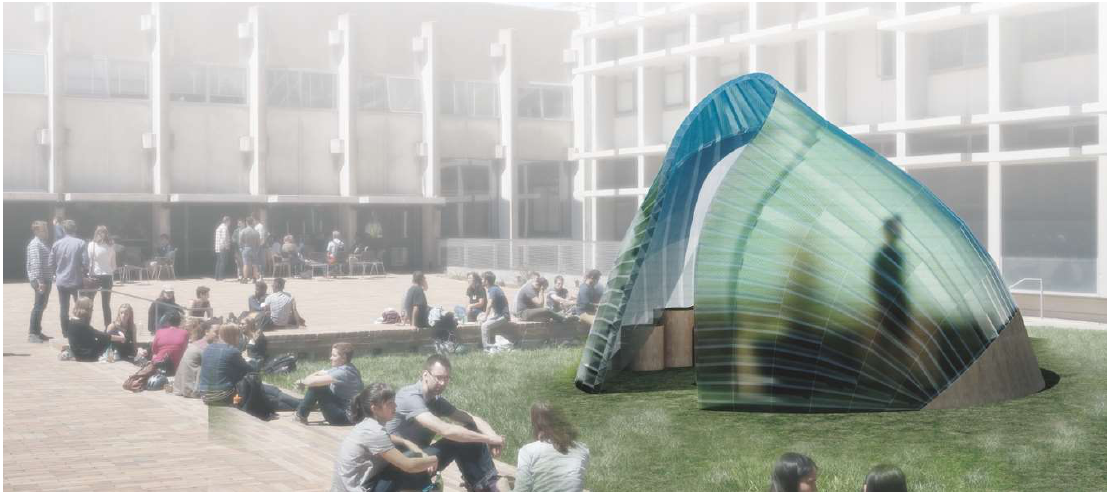
Figure 14. Rendering of the Studio One Research Pavilion 2017 in the courtyard of the College of Environmental Design (CED) at the University of California, Berkeley.